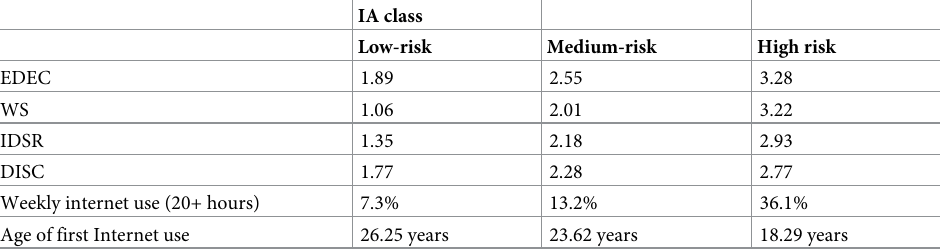
Table 8. IDS-15 dimension scores, weekly internet use and age of first internet use for each IA risk